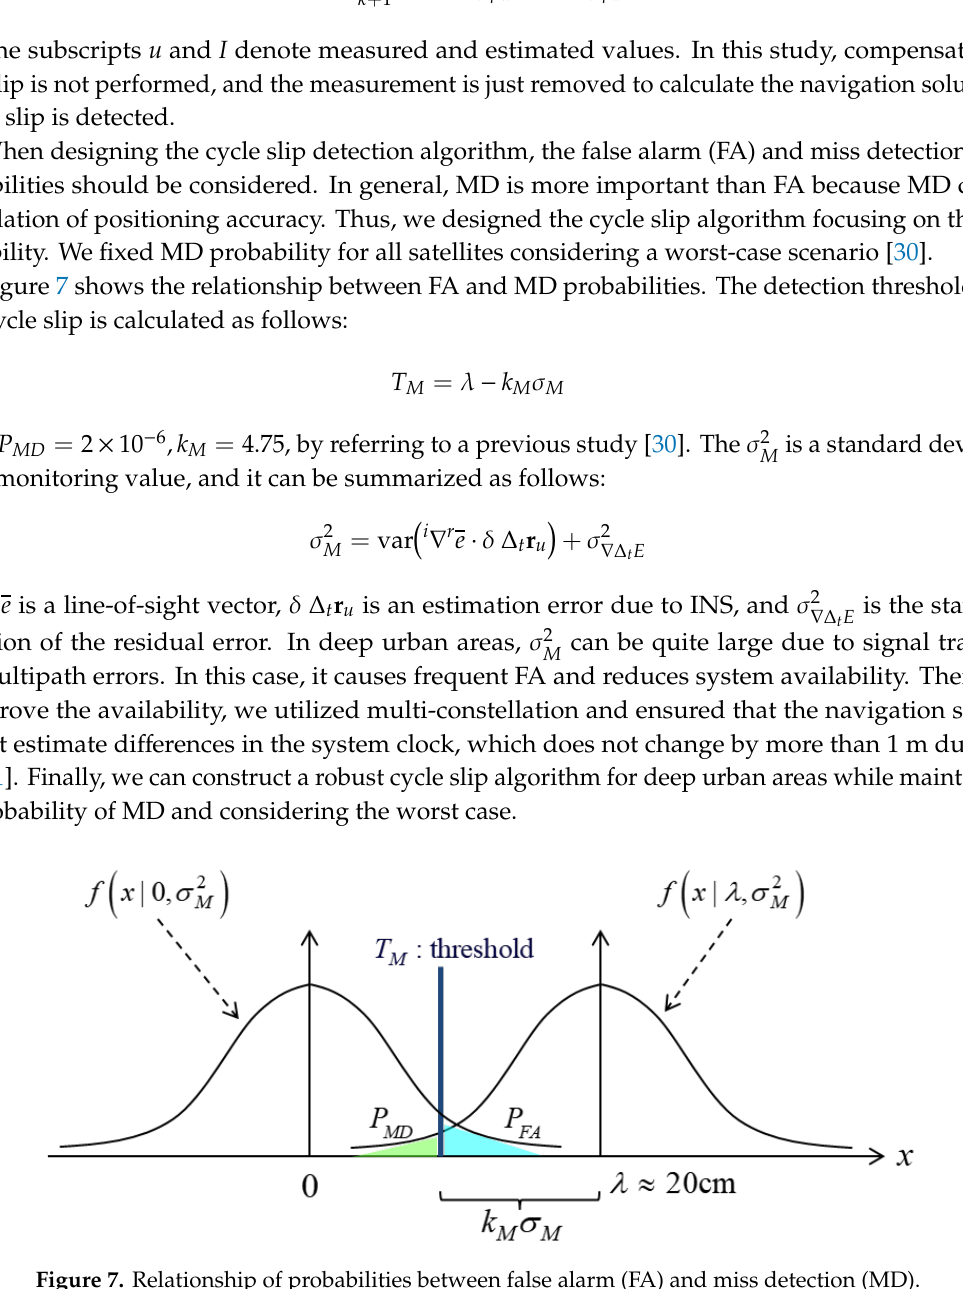
Figure 7. Relationship of probabilities between false alarm (FA) and miss detection (MD).